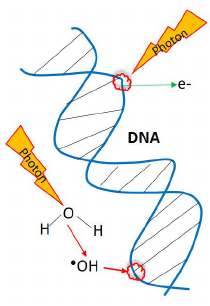
Figure 1. Scheme of the direct or undirect influence of the high-energy electromagnetic radiation on DNA.